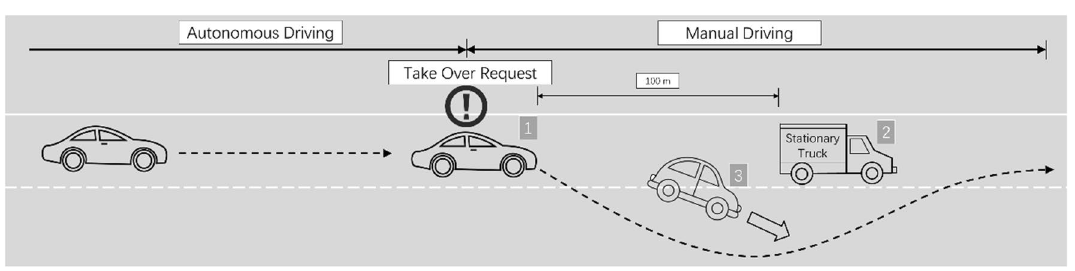
Figure 2. Scenario of takeover request and driving